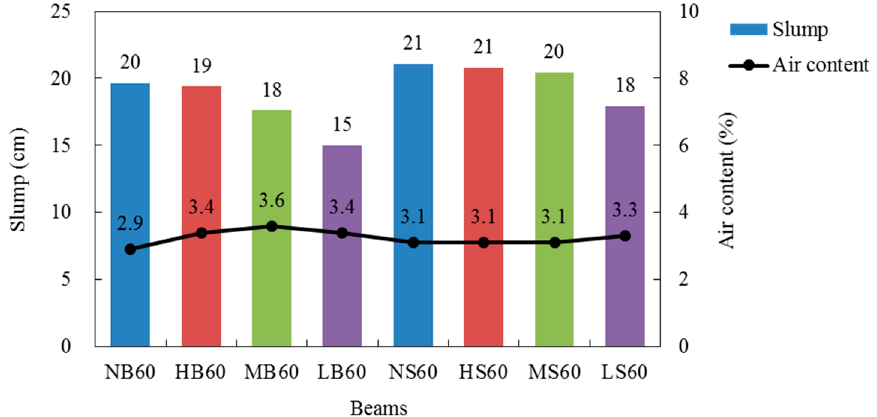
Figure 6. Slump and air content of fresh concrete.